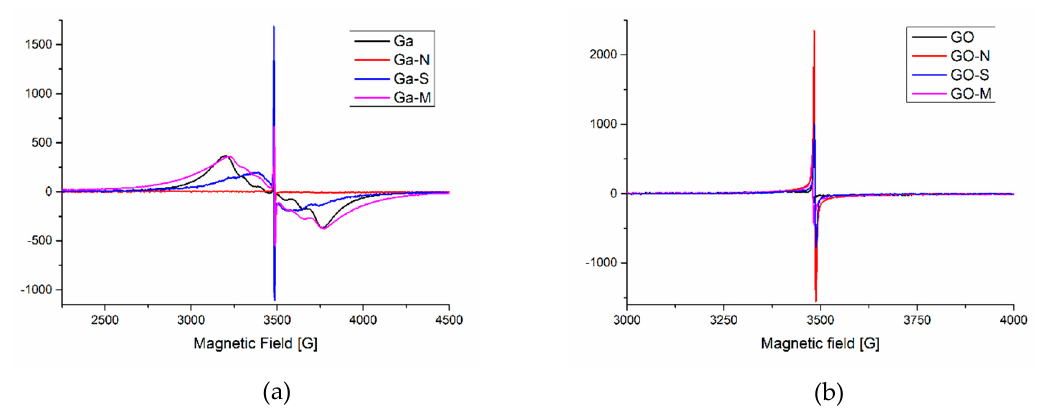
Figure 5. First derivative X-band cwESR spectra of the pristine and functionalized ( a ) Ga and ( b ) GO samples at room temperature.